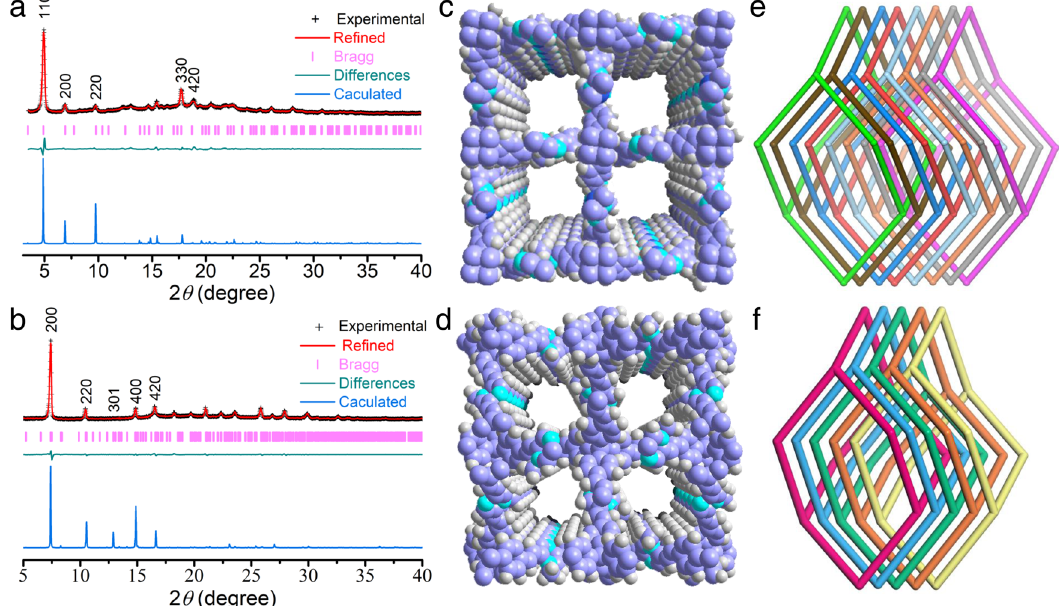
Fig.2|Structuralrepresentationsofionic3Dsp 2 carbon-linkedCOFs. PXRDpatternsof( a )TAPM-PZIand( b )TFPM-PZI.Structuralrepresentationsof( c )and( e )TAPM- PZI, and ( d ) and ( f ) TFPM-PZI, respectively (C, purple; H, grey; N, sapphire; I, navy